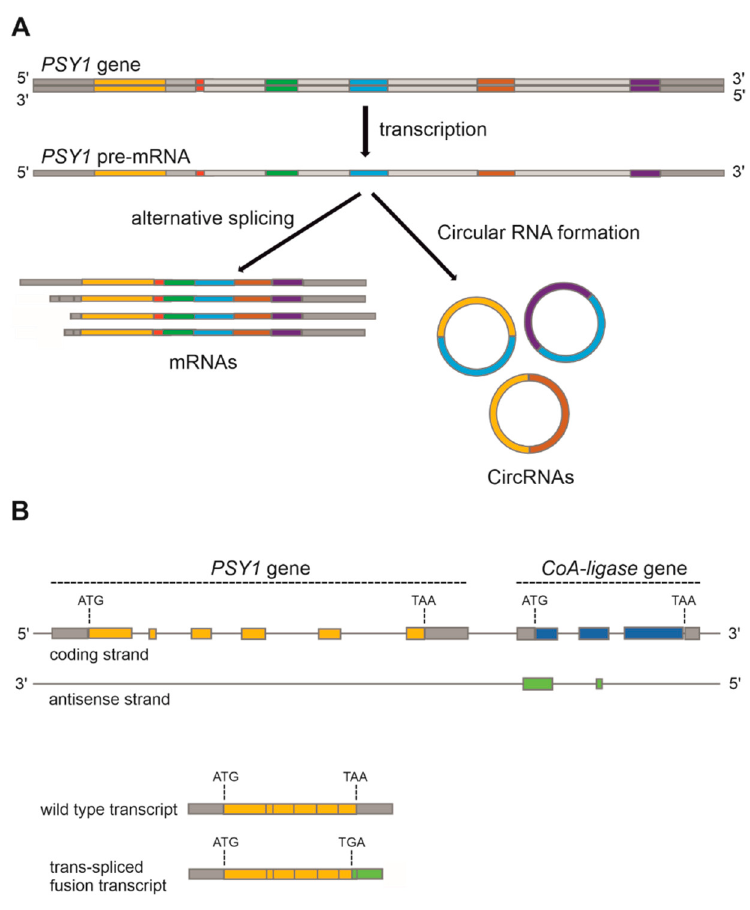
Figure 4. ( A ) PSY1 gene alternative RNA splicing mechanisms leading to different splicing variants and Circular RNAs (CircRNAs). The alternative mRNAs sequences correspond to the PSY1 transcript variants 1 ÷ 4 in “NCBI Solanum lycopersicon annotation release 103” (in: https://www.ncbi.nlm.nih. gov/gene/543988, 14 July 2021). The number and the colour of the exons in the CircRNAs are only indicative and do not reflect the real sequences. ( B ) PSY1 trans-spliced fusion transcripts with the adjacent CoA-ligase gene. Gene structures and intergenic distance are not in one-to-one